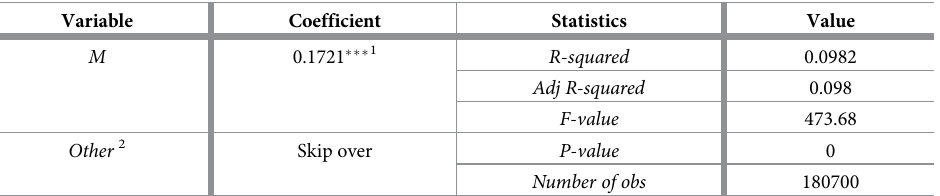
Table 2. The migration effect on the monthly